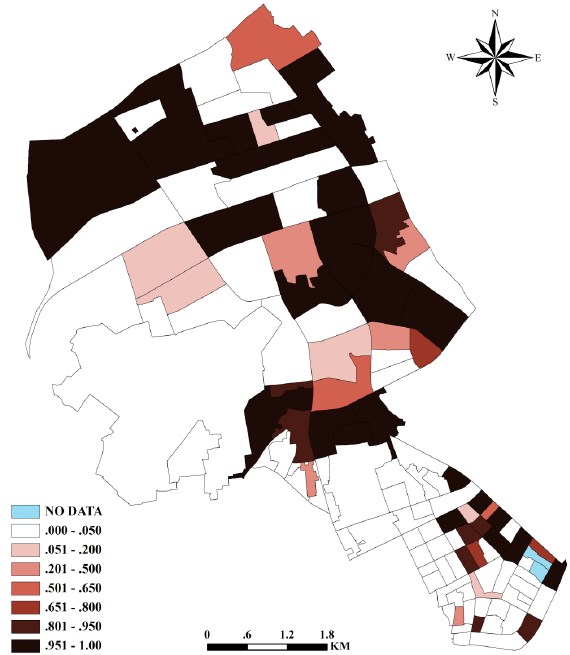
Figure 4. Posterior probabilities of neighborhoods that have a burglary risk greater than 1.0.